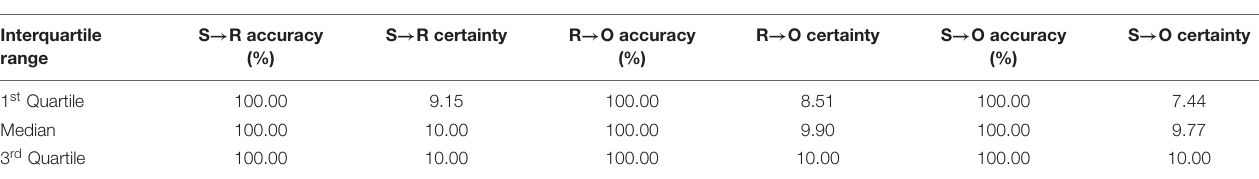
FIGURE 4 | Performance in the slips-of-action (A) and baseline test (B) depending on UPPS Sensation Seeking . UPPS Sensation Seeking is negatively associated with devaluation sensitivity indices (DSI) of both tests (Spearman correlations). TABLE 4 | Explicit knowledge (1st Quartile, Median, and 3rd